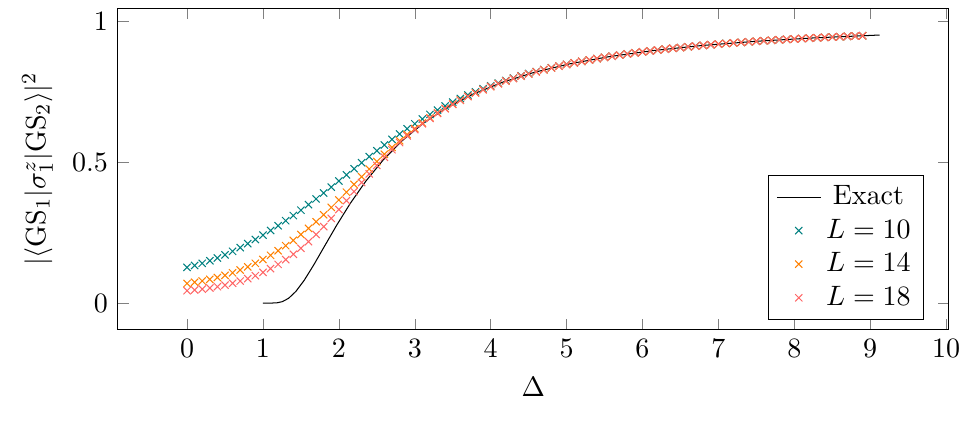
Figure 12: Form Factor between the two degenerate ground states at h − = h + = 0 in the thermodynamic limit with respect to the anisotropy ∆ from equation (5.48), given by the closed formula s 4 obtained by numerical exact diagonalization.